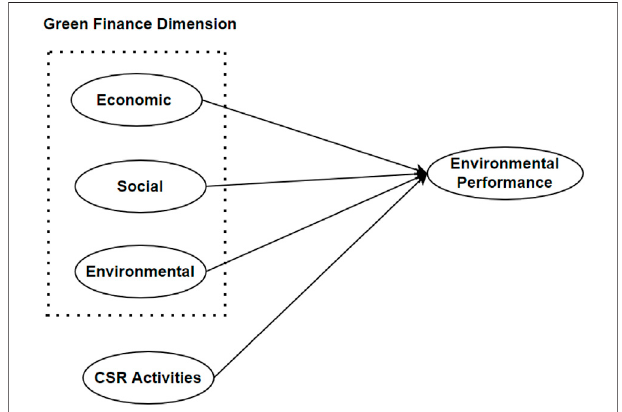
FIGURE 1 | Conceptual framework of the